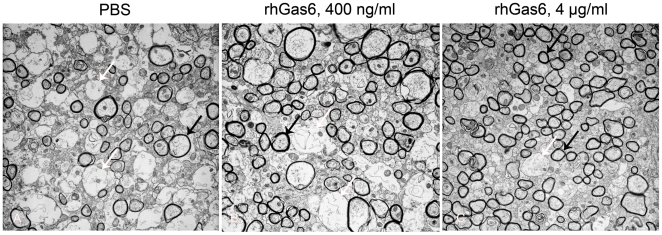
EM shows more myelinated axons in rhGas6-treated mice.Relative to PBS (A), the number of myelinated axons was significantly increased in mice treated with 400 ng/ml (B) and 4 µg/ml (C) rhGas6. Black arrows denote myelinated axons; white arrows show demyelinated, naked axons, ×5000.